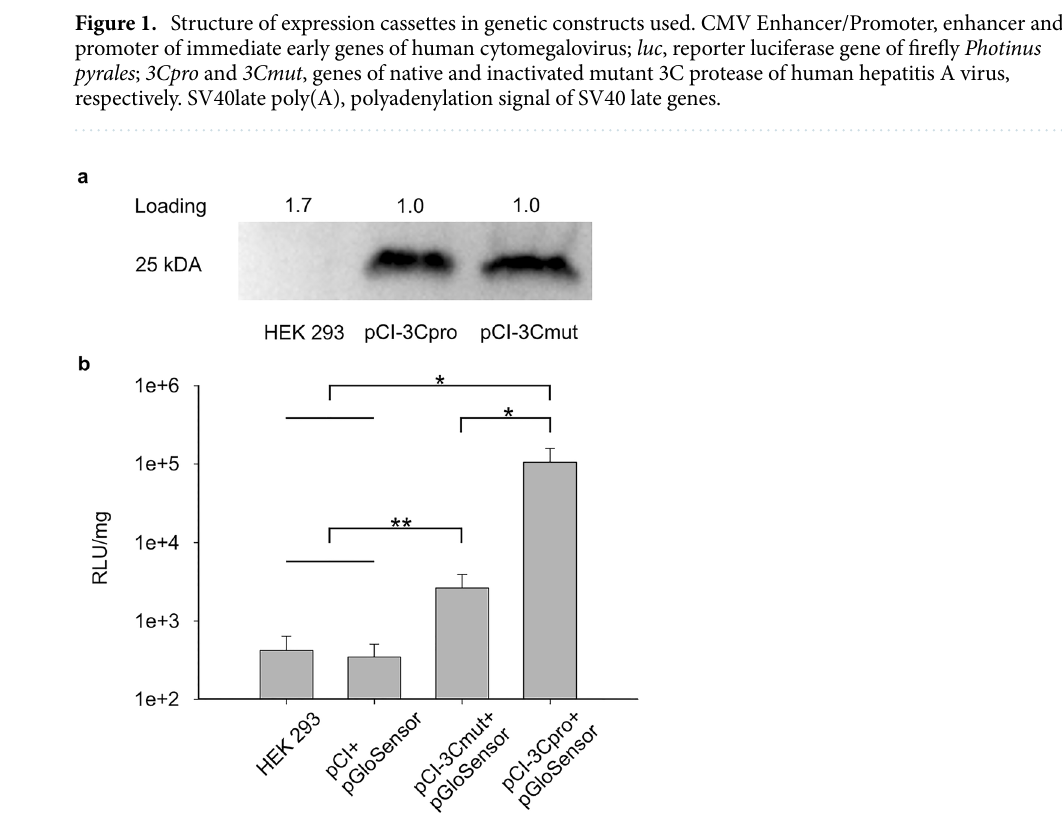
Figure 2. Accumulation of target proteins in HEK293 cells. ( a ) Western blot analysis of 3Cpro in HEK293 cells 24 h after transfection with pCI-3Cpro or pCI-3Cmut. Each lane contained a lysate of 200 000 cells. “Loading” indicates the relative total protein in the lane evaluated by the Stain-Free technique. Full-length blot image is presented in Supplementary Fig. S1. ( b ) Luciferase activity in lysates of HEK293 cells 15 h after transfection with mixture of pCI, pCI-3Cpro, or pCI-3Cmut with pGloSensor-30F-LRTQS (pGloSensor). Ordinate, relative luminescence units (RLU) normalized to 1 mg of total protein in cell lysates. The values were averaged for two independent experiments, in which three replicates were performed. Error bars indicate standard deviation (SD), * p < 0.001; ** p <